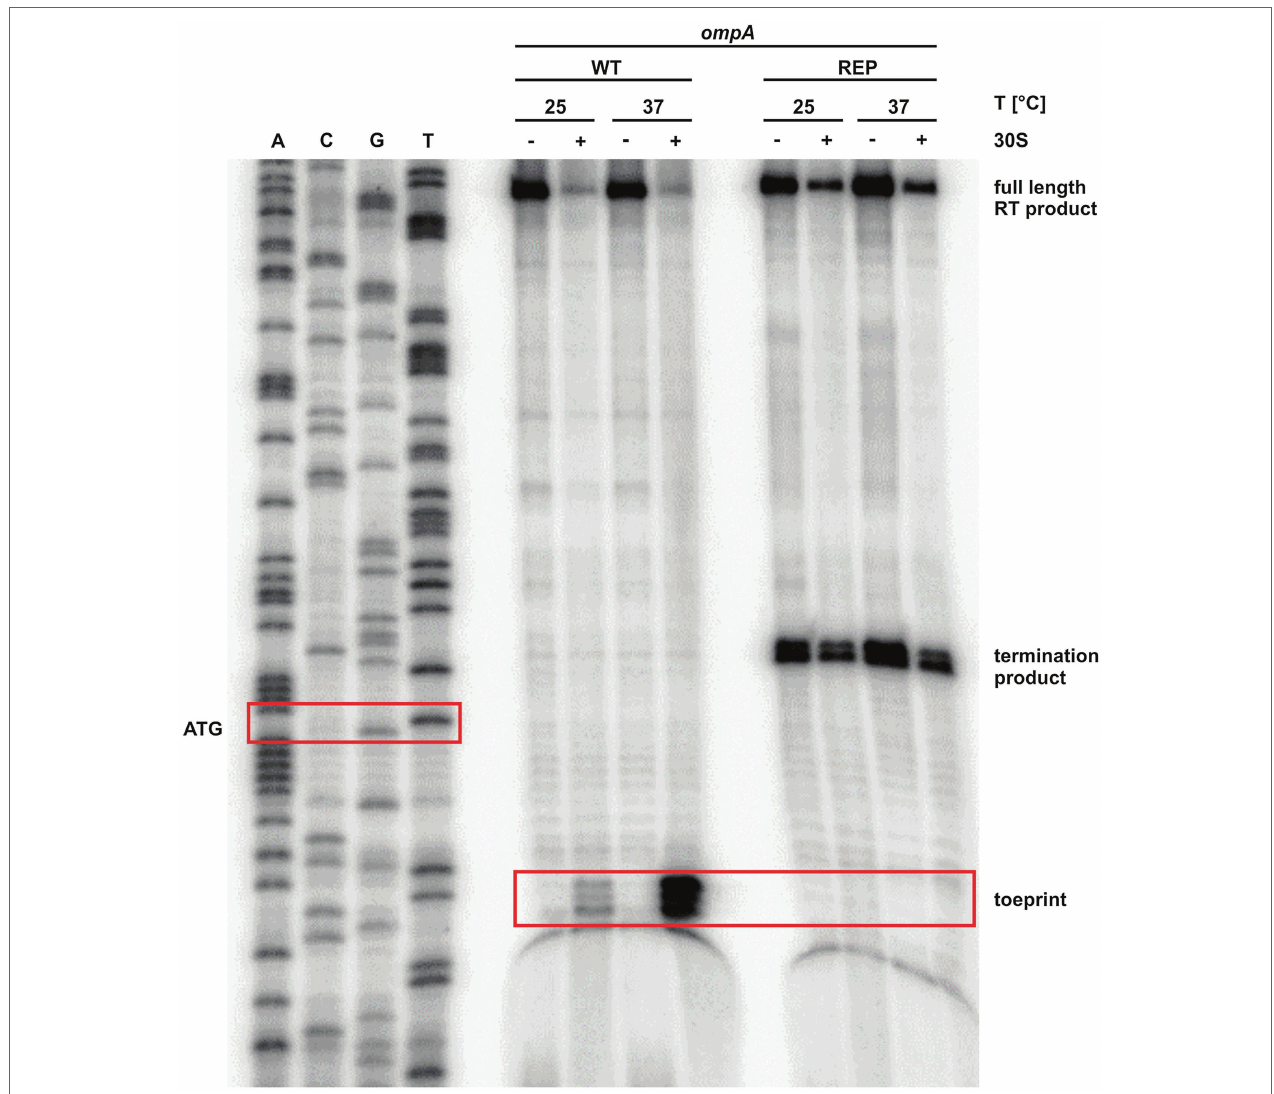
FIGURE 4 | The ribosome binds to the ompA transcript at 37 ° C. Primer extension inhibition of the ompA RNAT (WT) and its stabilized version (REP) at 25 and 37 ° C with (+) and without ( − ) the addition of 30S ribosomal subunits. The signals represent the full-length reverse transcription (RT) product, the premature termination product, and the toeprint signal (caused by ribosome binding). ACGT lanes indicate sequencing reactions. Position of ATG and the toeprint signal is highlighted by red boxes. Experiment was carried out at least three